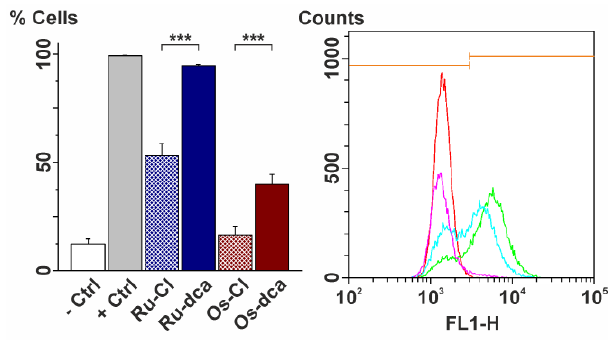
Figure 6. ( Left ) The results of the flow cytometry studies of cytochrome c release at the A2780 cells treated for 24 h by the IC 50 concentrations of complexes Ru-Cl (dashed blue), Ru-dca (blue), Os-Cl (dashed red) and Os-dca (red); white = negative control (− Ctrl), grey = positive control (+Ctrl), p < 0.005 (***). ( Right ) The representative histogram of the flow cytometry studies of cytochrome c release, showing the fluorescence intensities in FITC-H channel in the A2780 cells treated by complexes Ru-dca (pink) and Os-dca (blue), given together with the negative (green) and positive (red) controls. Orange line segments show the edge between low and high fluorescence populations.